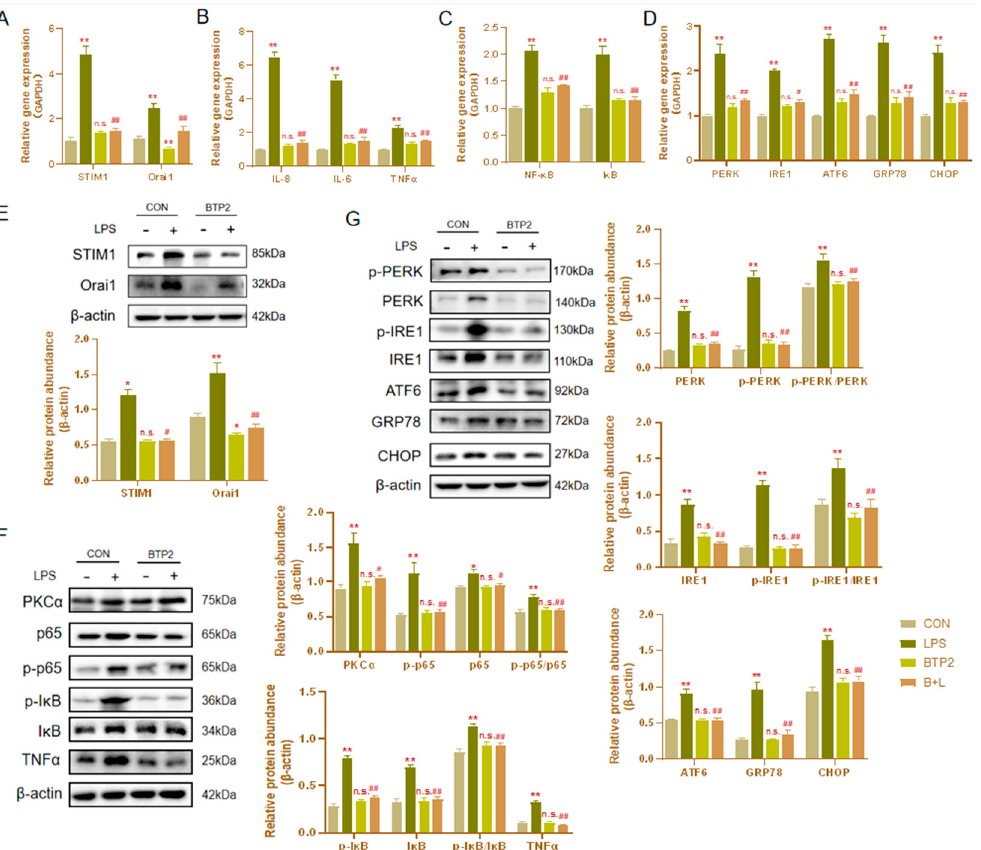
Figure 6. Effects of the Orai1 inhibitor BTP2 on LPS-induced inflammation and endoplasmic reticulum stress (ERS) in BHEC. Treatments: BHEC were cultured in a BTP2-free medium for 24 h. CON, complete control groups; LPS, cells treated with 16 μ g/mL LPS for 1 h; BTP2, pretreatment with 8 μ g/mL BTP2 for 6 h without LPS treatment; LPS + BTP2, 8 μ g/mL BTP2 for 6 h, followed by 16 μ g/mL LPS for 1 h. ( A – D ) Expression levels of STIM1/Orai1 and the genes related to inflammatory cytokines (NF- κ B, I κ B, IL-6, IL-8, and TNF α ) and ERS (PERK, IRE1, ATF6, GRP78, and CHOP) were shown. Gene expression levels were normalized to that of GAPDH. ( E – G ) Protein abundance levels of STIM1/Orai1, PKC α , p65, p-p65, I κ B, p-I κ B, TNF α , PERK, p-PERK, IRE1, p-IRE1, ATF6, GRP78, and CHOP in BHEC, showing representative bands of the Western blot analysis and the quantified volume of specific bands. The results are presented as the means ± SEM. * p < 0.05, ** p < 0.01 indicate a significant difference between the LPS groups and the control groups; n.s. indicates that there was no significant difference between the BTP2 group and the CON group. # p < 0.05, ## p < 0.01 indicate a significant difference between the BTP2 pretreatment groups and the LPS groups.